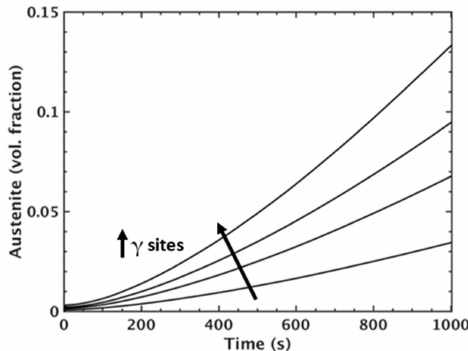
Figure 11. MICRESS ® simulation results for austenite volume fraction during intercritical annealing for simulations incorporating di ff erent amounts of austenite nucleation sites ( γ